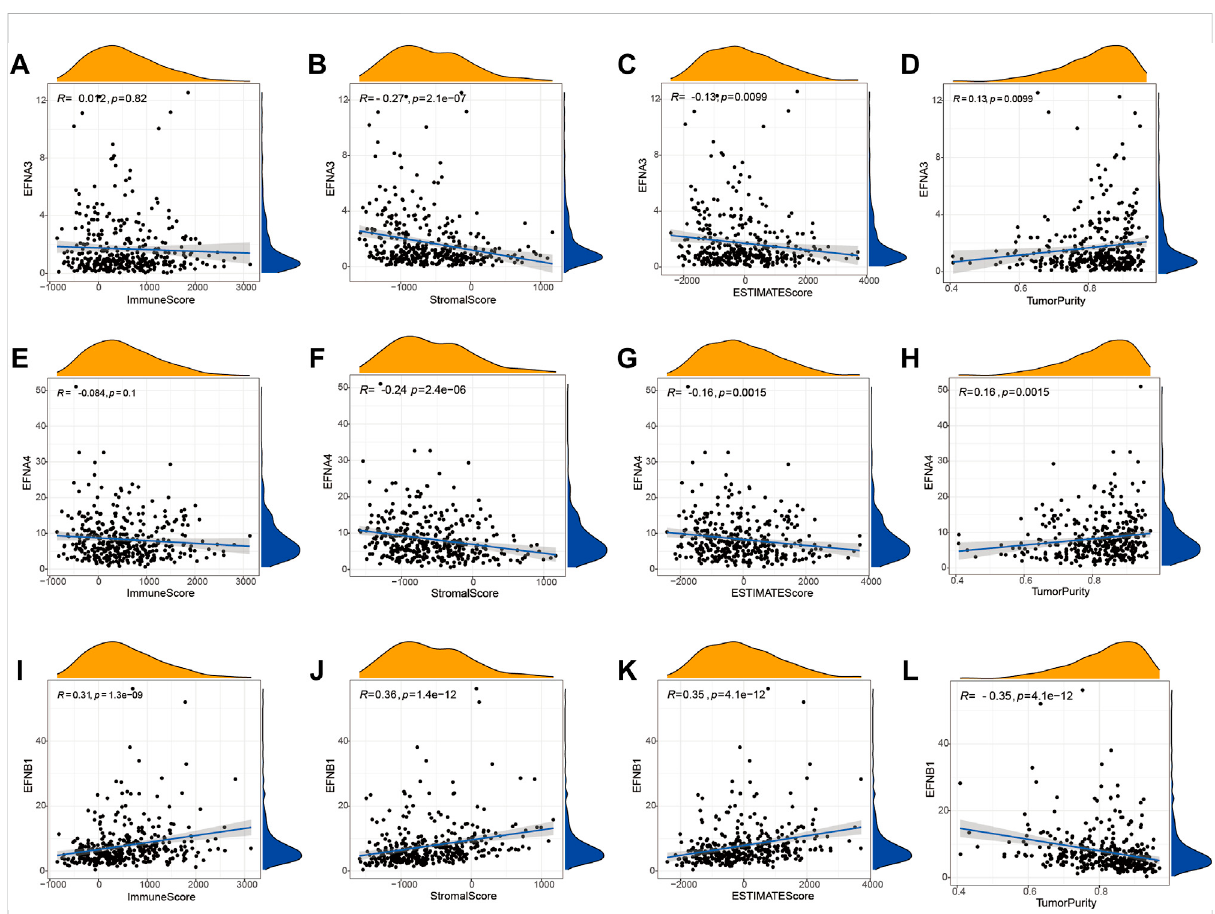
FIGURE 6 CorrelationbetweentheexpressionofprognosticephringenesandthetumormicroenvironmentbasedontheESTIMATEalgorithm. (A – D) The correlation betweenEFNA3expressionand immune/stromal/ESTIMATE/tumorpurity scores. (E – H) The correlation between EFNA4 expression and immune/stromal/ESTIMATE/tumor purity scores. (I – L) The correlation between EFNB1 expression and immune/stromal/ESTIMATE/tumor purity scores. R: Spearman ’ s rank coef fi